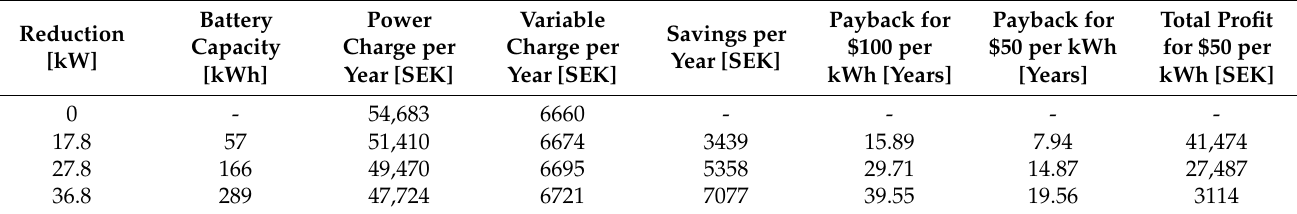
Table 1. Economic calculations before and after reduction of the power peak.